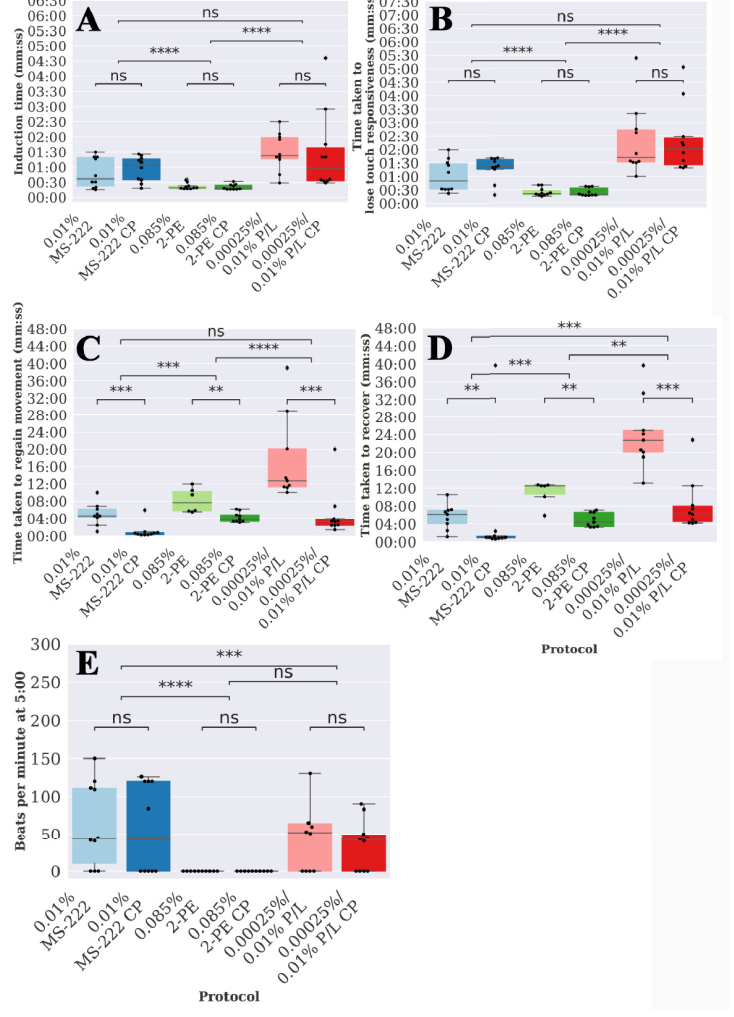
Fig 3. Protocols 1, 4, 5 and 6 vary in the time taken to induce, lose touch responsiveness, regain movement, regain equilibrium as well as respiratory rate. Boxplots of the time taken to (A) induce anaesthesia, (B) lose touch responsiveness, (C) regain movement post anaesthesia and (D) regain equalibrium post anaesthesia for each protocol 1–6 as defined in Table 1. (E) Boxplot of the respiratory rate (breaths per minute—bpm) at 5 minutes for each protocol. Stars indicate significant difference of subsequent repeats as determined using the Mann-Whitney U-test. ns = not significant, ‘ � ’ indicates p < 0.05, ‘ �� ’ indicates p < 0.01, ‘ ��� ’ indicates p < 0.001 and ‘ ���� ’ indicates p < 0.0001.